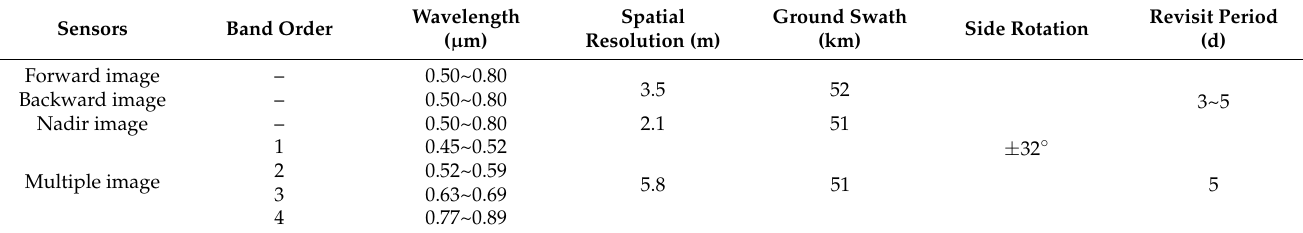
Table 1. Main parameters of the ZY3 satellite, collected from http://www.satimage.cn, accessed on 18 March 2021. Sensors Band Order